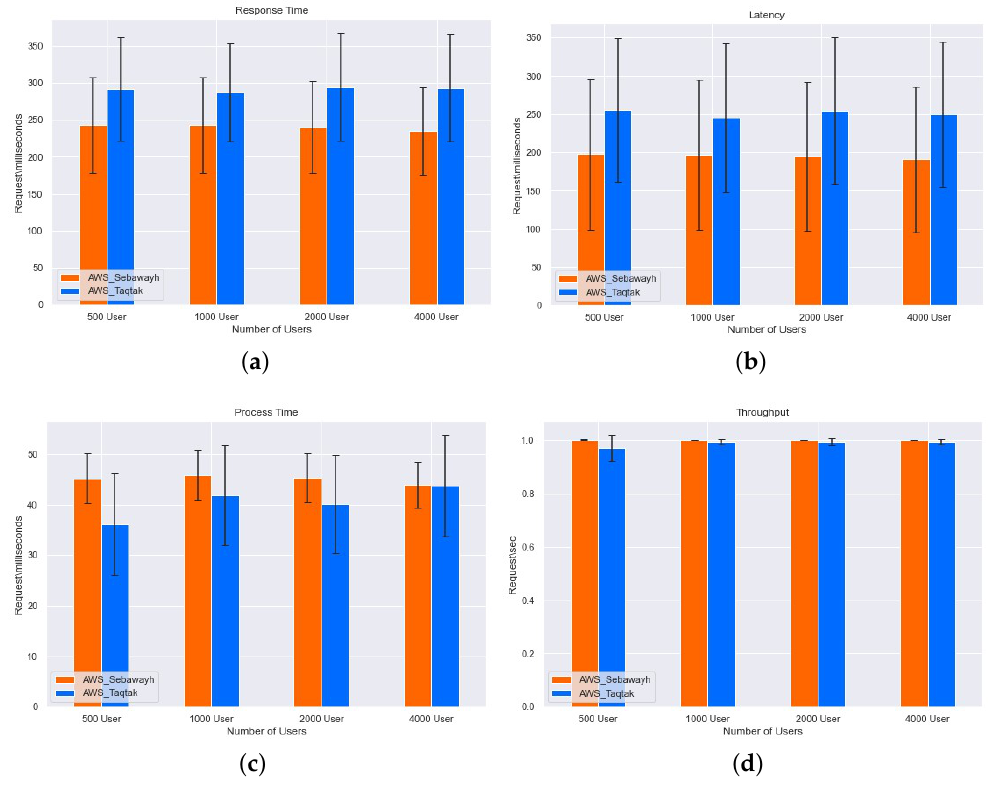
Figure 2. Results for different cloud-API-based applications on Amazon AWS EC2. ( a ) Response time of both APIs on AWS EC2. ( b ) Latency of both APIs on AWS EC2. ( c ) Processing time of both APIs on AWS EC2. ( d ) Throughput of both APIs on AWS